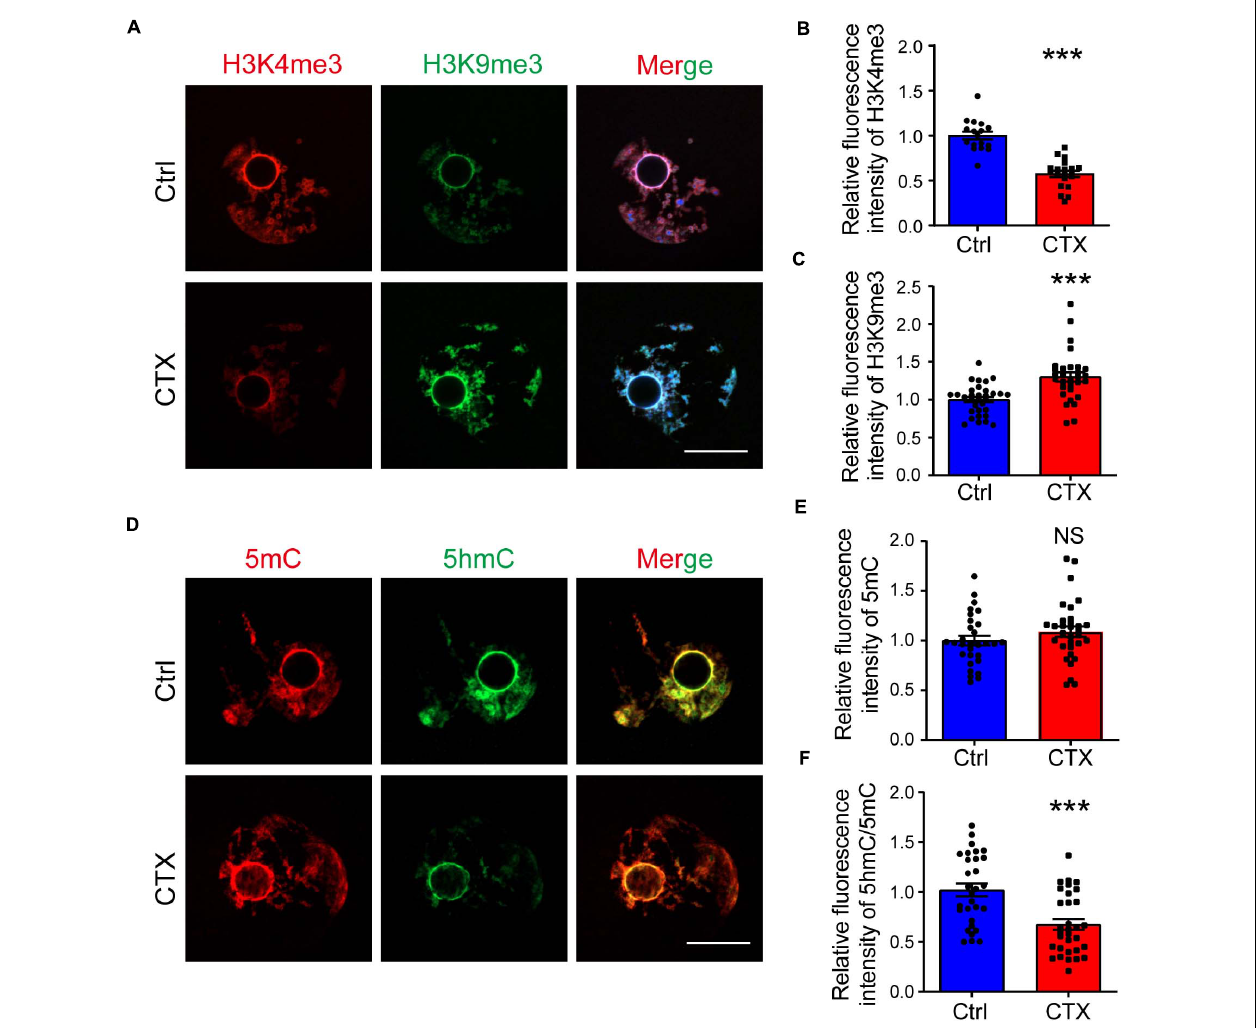
FIGURE 4 | CTX affects histone modification and DNA methylation levels in fully grown GV oocytes. (A) Immunostaining of H3K4me3 and H3K9me3 in fully grown GV oocytes after CTX exposure. Red fluorescence represents H3K4me3, while green fluorescence represents H3K9me3. (B,C) Measurement of increased levels of relative fluorescence intensity of H3K4me3 and decreased levels of H3K9me3 in post-CTX oocytes. (D,E) Immunofluorescence staining of 5 (cid:48) -methylcytosine (5mC) and 5 (cid:48) -hydroxymethylcytosine (5hmC) in oocytes. (F) Statistical analysis of the 5mC level showed no significant difference but a decrease in the 5hmC/5mC ratio. Scale bar = 50 µ m. The intensity was measured by Image J software and data was presented as mean ± SEM. NS, no significant, *** P < 0.001.